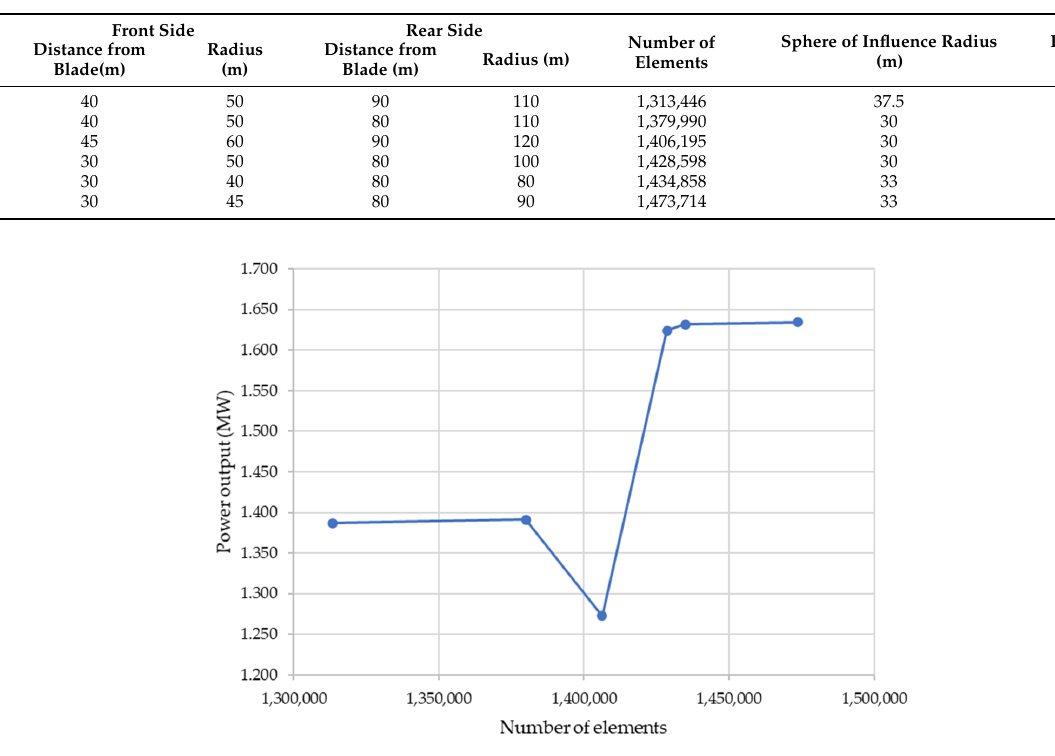
( b ) Figure 4. ( a ) Periodic computational domain and boundary conditions; ( b ) hybrid mesh close to the blade. In the table, 10 m · s − 1 and 15 m · s − 1 were simulated to indicate the impact of wind speed on the HAWT performance in dusty environment. Initially, air flow over the blade was simulated and afterwards it was simulated with the dust conditions, so that along with the power output, the whole flow field could be compared and discussed. The blade